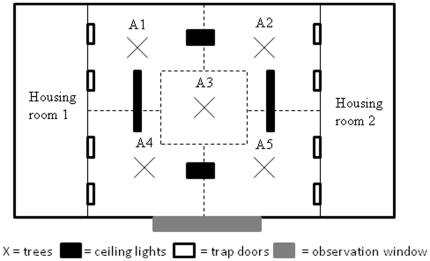
The layout of the experimental room, used to assay personality (see text and [25] for detailed description of methodology).